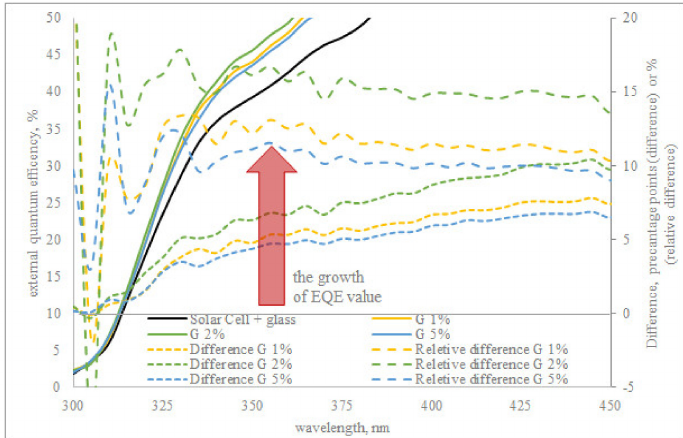
Figure 7. The best improvement of EQE for G pigment in only-PMMA variant.